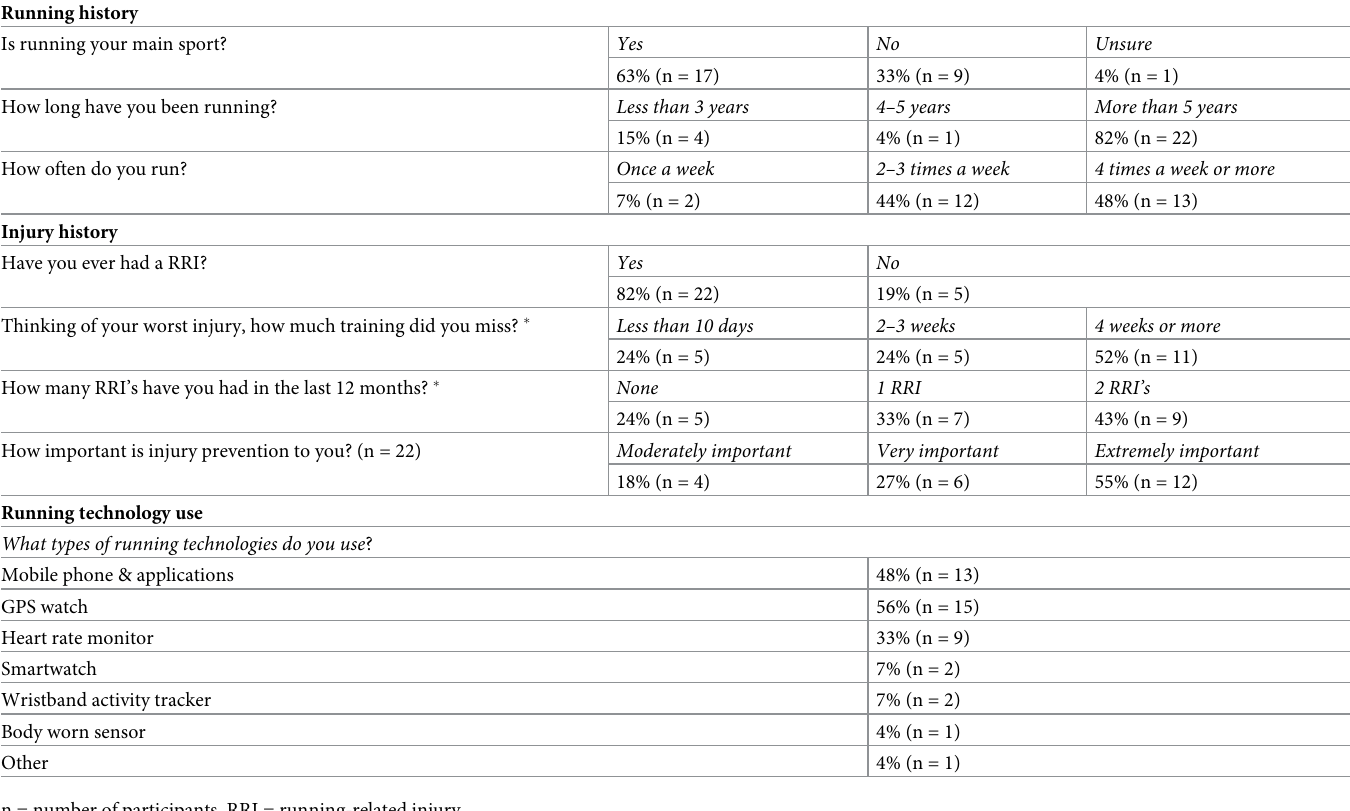
Table 1. Participant running and injury history (n =